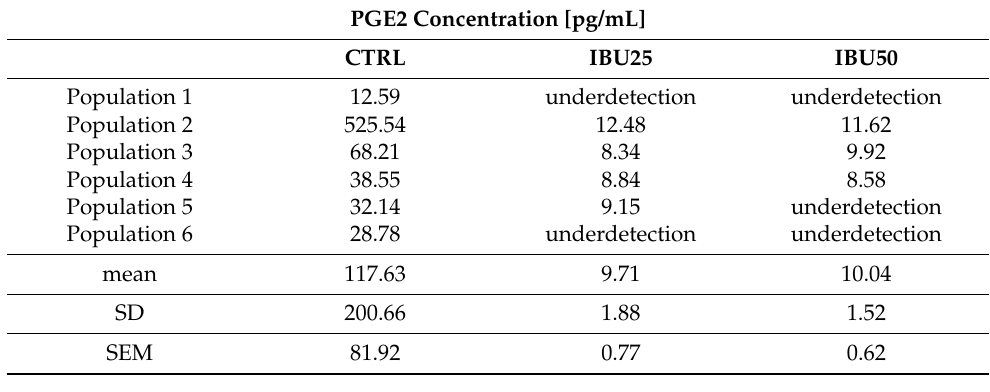
Table 2. hBM-MSCs secretion of PGE 2 after ibuprofen treatment. PGE 2 concentration in hBM-MSCs supernatants collected from 6 different populations was quantified with ELISA immunoassay after 24 h of incubation with 25 µg/mL or 50 µg/mL ibuprofen. The amount of PGE 2 (pg/mL) secreted by each study population (assay range: 7.8–1000 pg/mL).